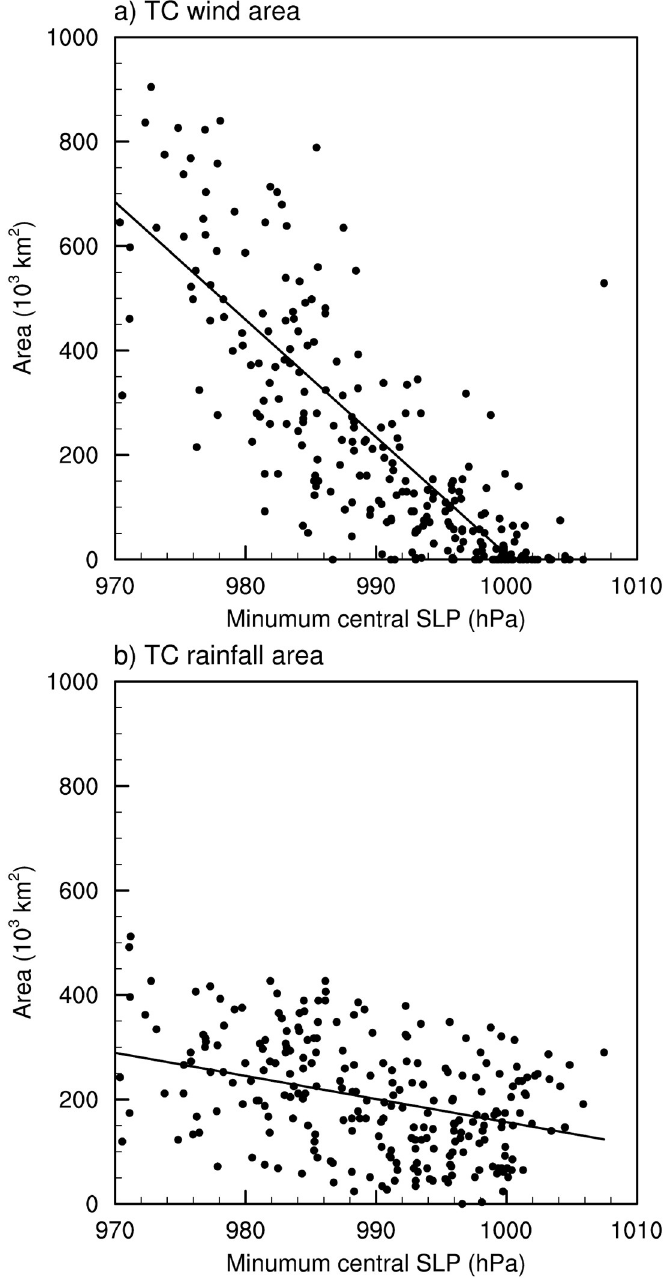
Fig 5. Distributions of the (a) wind area, and (b) rainfall area according to the minimum central SLP. The solid line in each plot denotes the linear regression line.